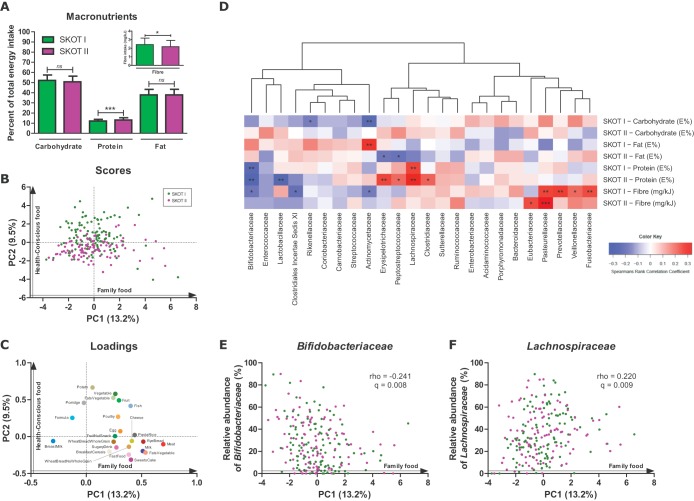
Complementary diet affects late-infancy gut microbiota composition. (A) Macronutrient intake in SKOT I and II is expressed as a mean percentage of total energy intake (E%) from carbohydrates, protein, and fat, whereas fiber intake is expressed in milligrams per kilojoule, with error bars indicating standard deviations. (B and C) PCA plot of consumption of the 23 food groups (grams per day per kilogram of body weight) for each individual in SKOT I and II (n = 217), resulting in principal component 1 (PC1), designated family food, and PC2, designated health-conscious food. (D) Heatmap illustrating hierarchical clustering of Spearman’s rank correlations between relative abundances of family-level gut microbes and macronutrient intake. *, P < 0.05; **, P < 0.01; ***, P < 0.001. (E and F) Spearman’s rank correlations between family food and relative abundances of Bifidobacteriaceae and Lachnospiraceae. q values are false-discovery-rate-corrected P values.